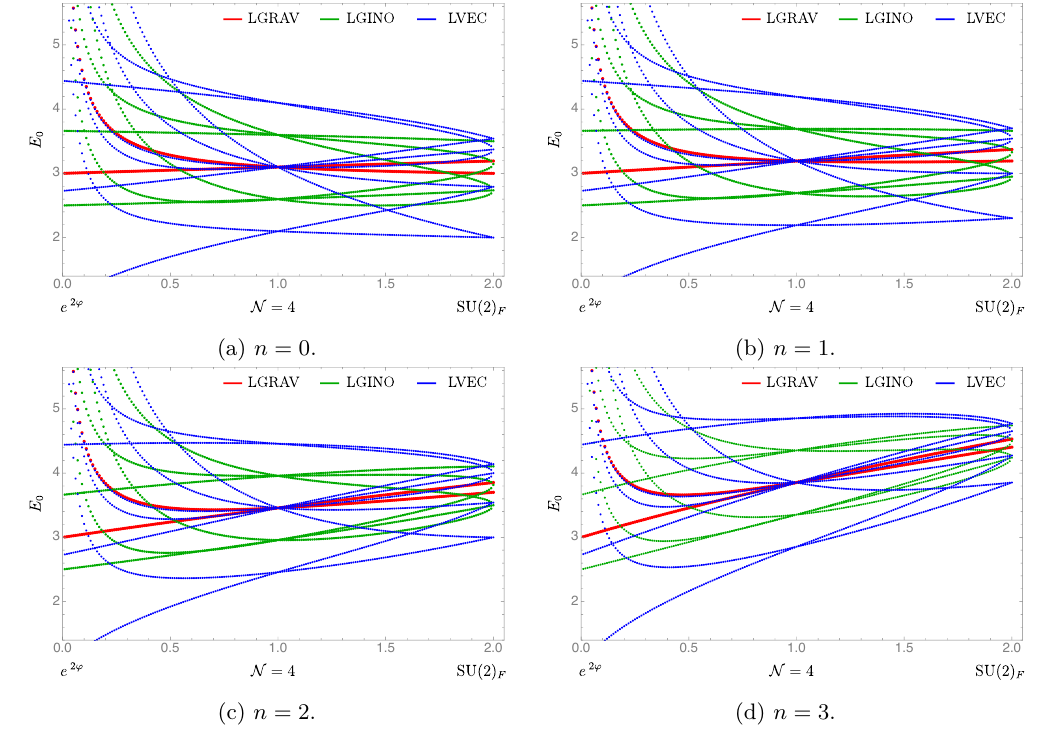
Figure 4 . N = 2 multiplets at KK levels ‘ = 1 and n = 0 , . . . , 3 on Family II at χ = 0 , with T = 2 π .